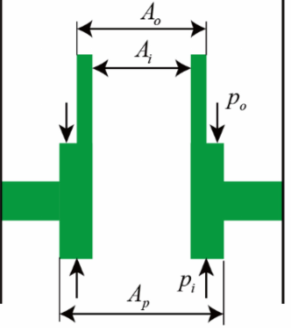
Figure 3. Schematic diagram of piston